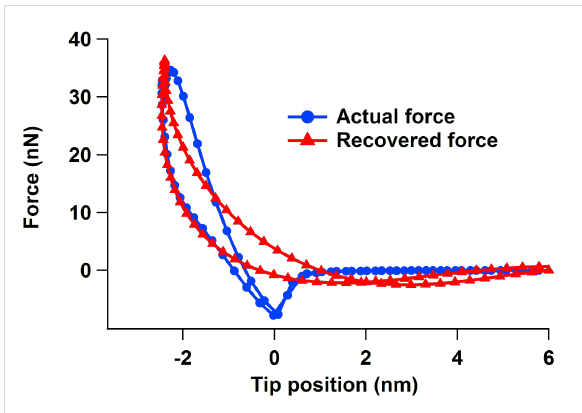
Figure 5: Example of force curve distortion for a case in which both conservative and dissipative interactions are present. The recovered curve uses a frequency cutoff of one harmonic above the torsional resonance frequency, similar to what is customary in experiments, and contains a very shallow and shifted minimum which differs for the ap- proach and retract (compare to Figure 6b in [11], which shows the high-quality force curve recovered by using all available harmonics). The sample modulus of elasticity in this simulation is 2 GPa. The force curve was simulated as the sum of a conservative Hamaker–Hertzian contact with a height-dependent viscous term [14] (this combination of models does not consider surface depression or recovery, so the loca- tion of the force minima is the same for the tip approach and